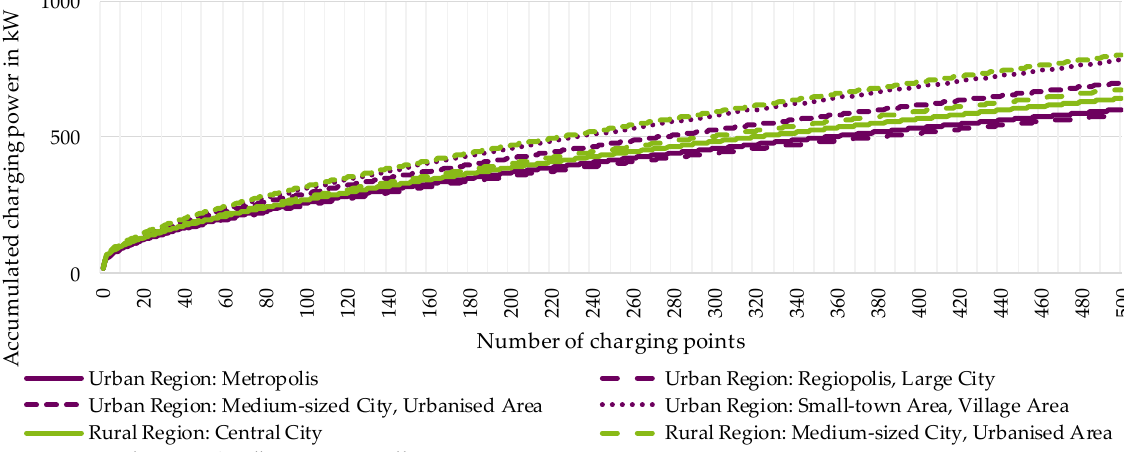
for seven area types.